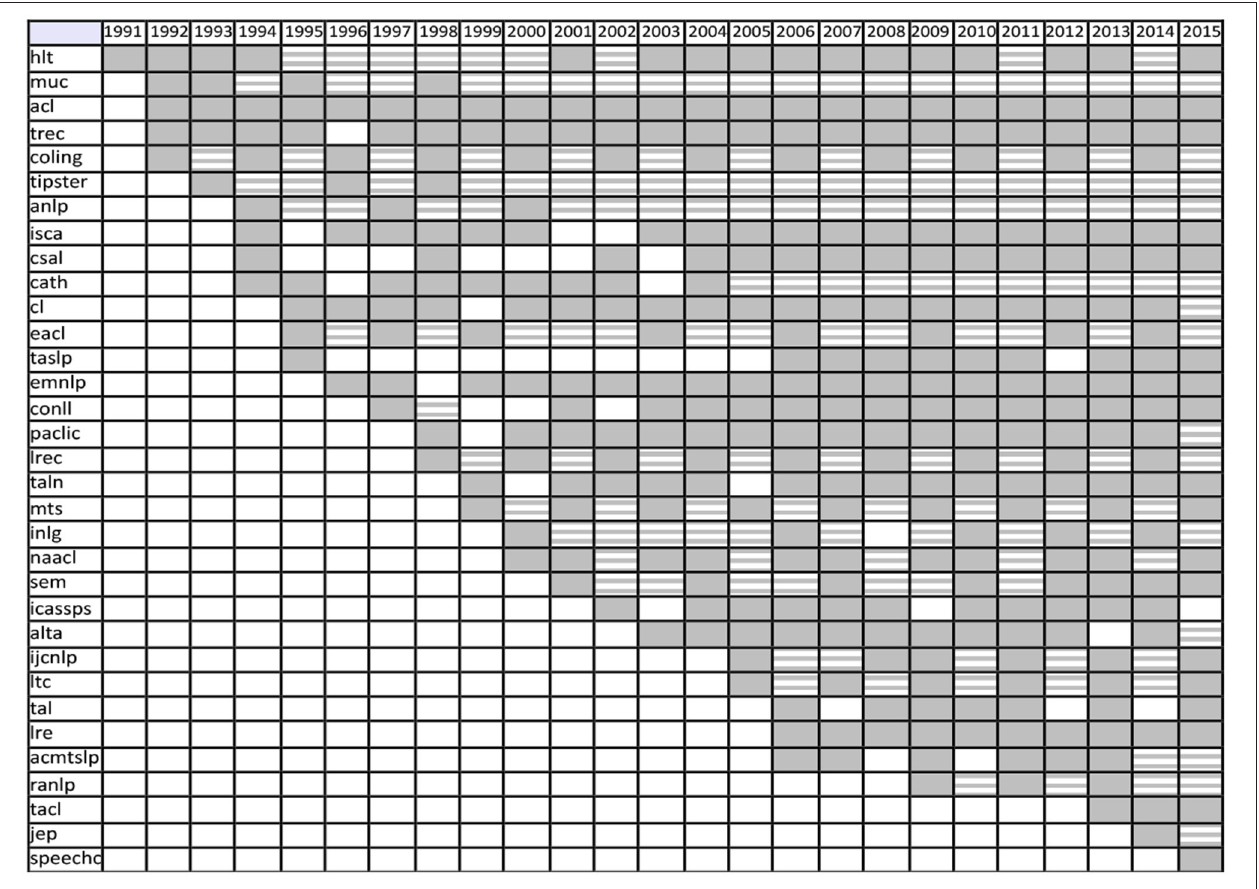
FIGURE 21 | Propagation of the mention of the “Wordnet” resource in NLP4NLP 12 conferences and